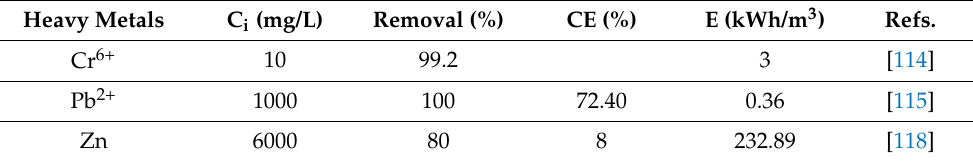
Table 5. ED performances in heavy metal